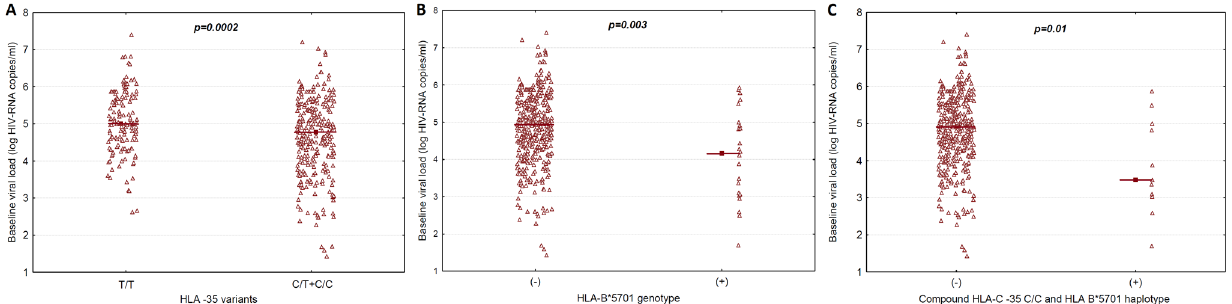
Fig 1. The relationship between pretreatment HIV plasma viremia and (a) HLA-C locus -35 genotypes for T/T homozygotes vs. C allele carriers (C/T +C/C), (b) HLA B * 5701(+) vs HLA B * 5701(-) genotype, and (c) compound HLA-C locus -35 C/C and HLA B * 5701 (+) haplotype. Raw values for each genotype are presented as triangles, means as squares. For statistics t-test was used.